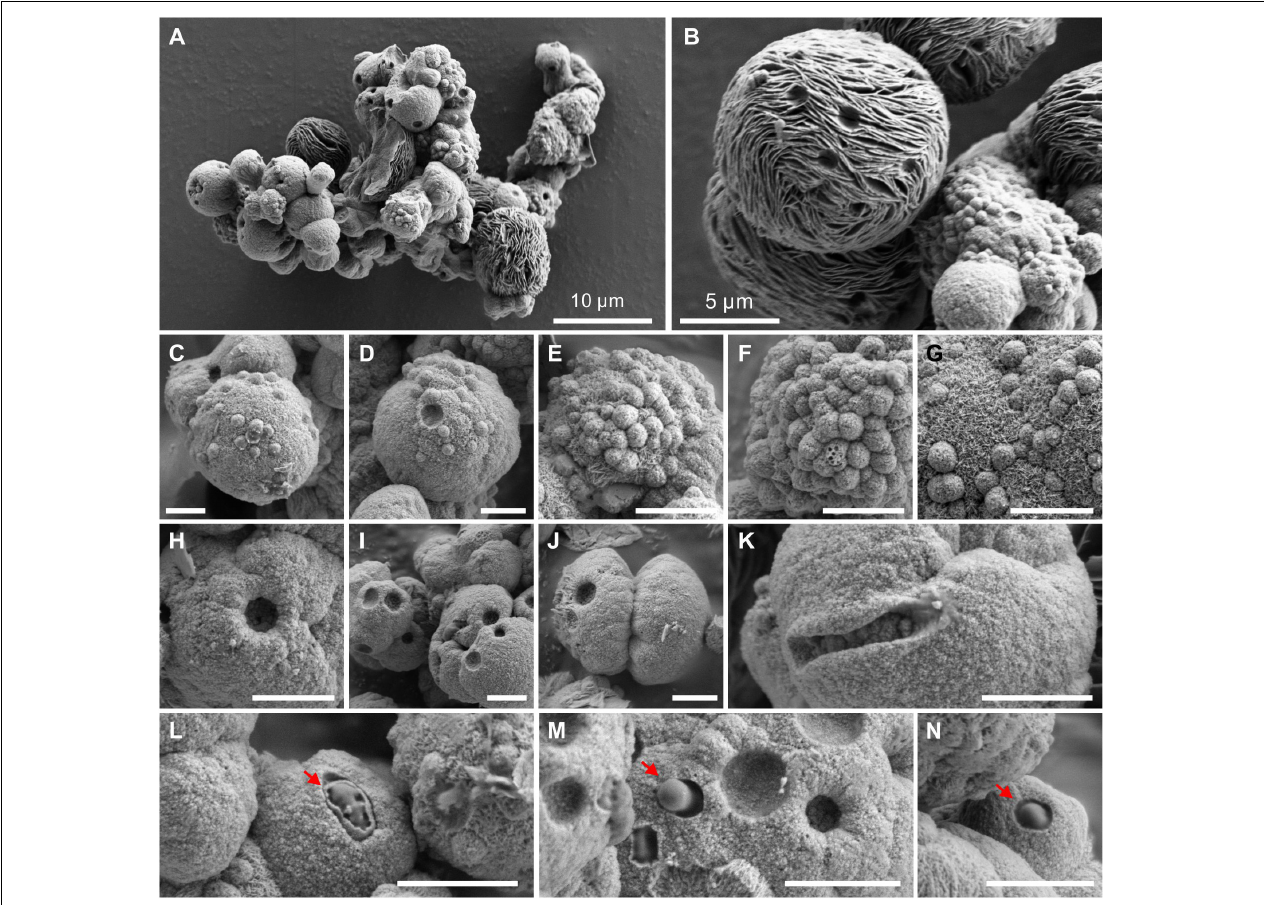
FIGURE 6 | Morphologies of protodolomite induced by Vibrio harveyi QPL2 in LB media with a Mg/Ca molar ratio of 12. (A) Protodolomite mineral aggregates. (B) A spheroidal huntite crystal with a fibrous and flakey structure. (C–G) Numerous spheroids with a diameter of about 0.5–1.0 µ m on the surface of protodolomite. (H–K) Pinholes with a diameter of approximately 1 µ m on the knobby surfaces of protodolomite. (L–N) Living bacteria enveloped within the mineral crust. The scale bar of the images (C–N) is 2 µ